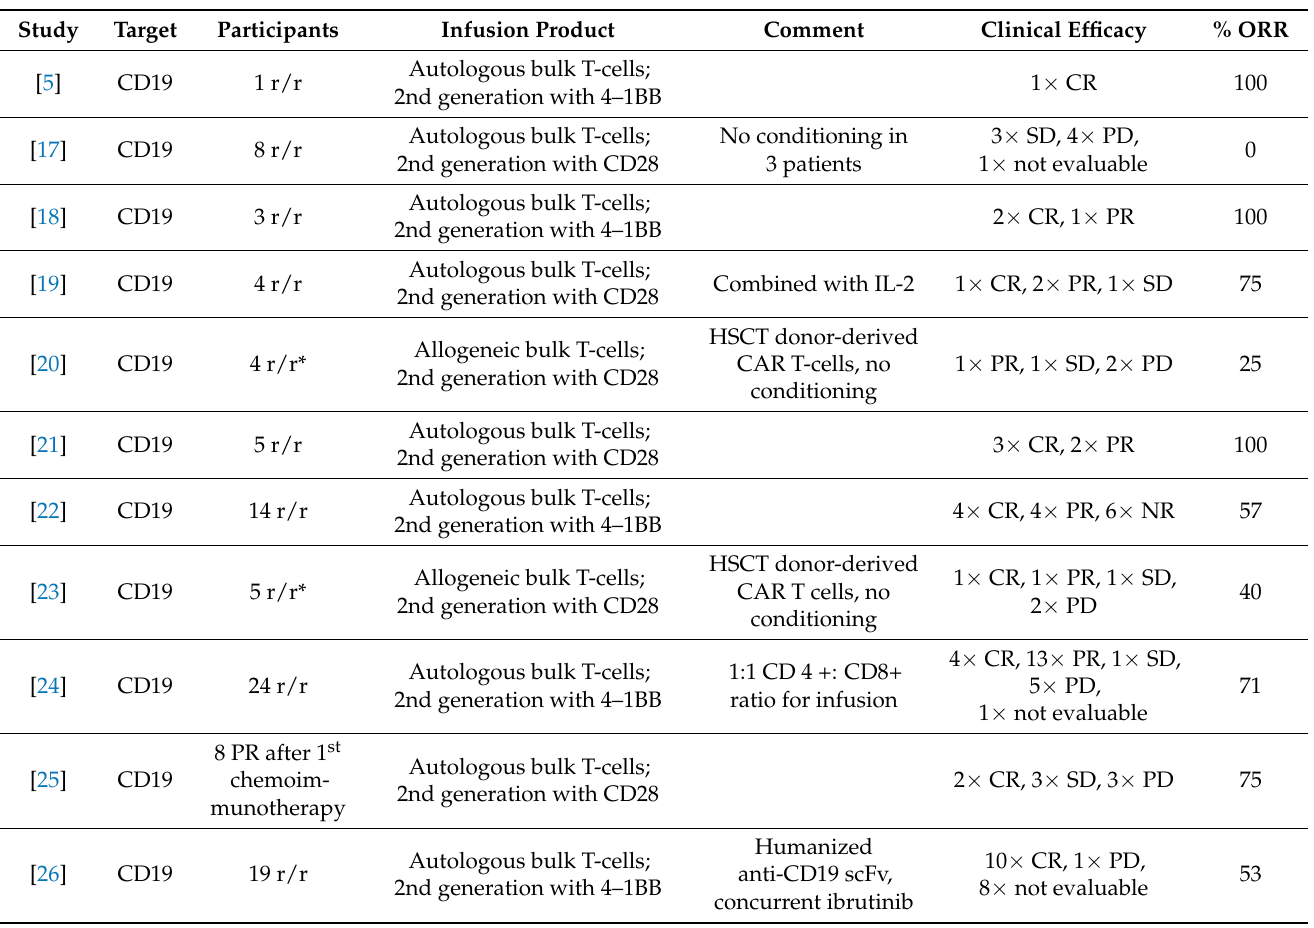
Table 1. CAR T-cell clinical trials carried out in CLL to date. r/r, relapsed/refractory; *, relapsed after hematopoietic stem cell transplantation (HSCT); ORR, overall response rate; CR, complete response; PR, partial response; SD, stable disease; PD, progressive disease; NR, no response; NK, natural